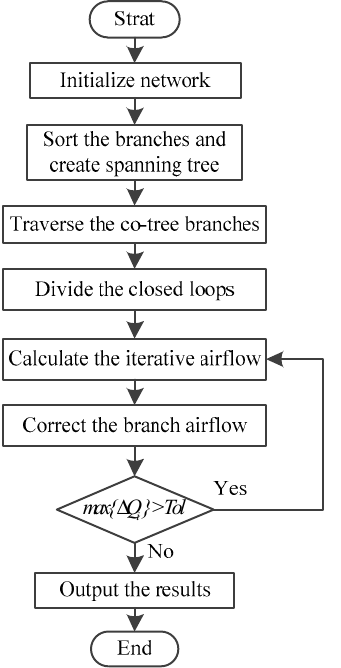
Figure 7. Flow chart of the improved solution method.